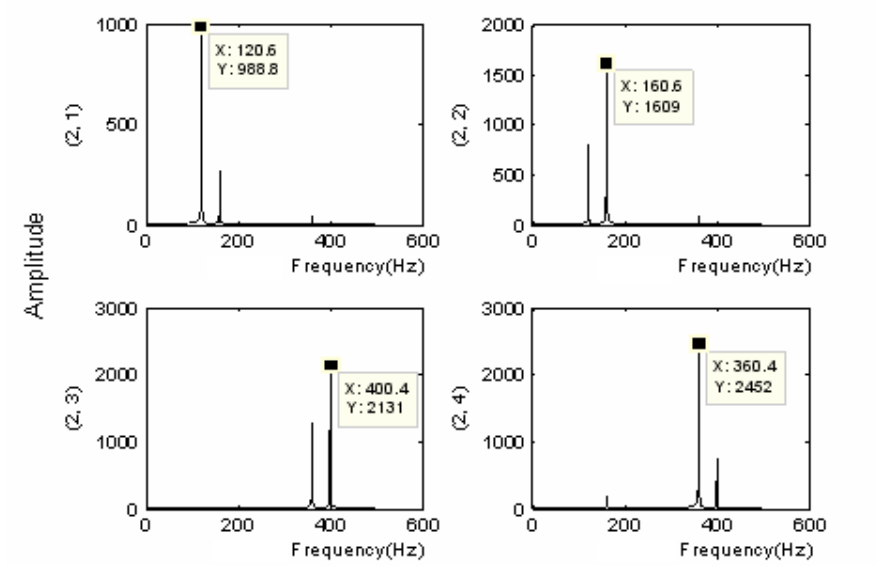
Figure 2. Node spectrogram about redundant lifting wavelet packet decomposition of simulation